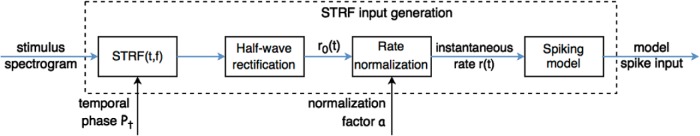
Illustration of model input generation process. The stimulus spectrogram was convolved with STRFs modeled after midbrain neurons, followed by half-wave rectification, then rate normalization to generate an instantaneous output-firing rate. This firing rate was then used to generate spikes using a spiking model (see Materials and Methods for details). The values of temporal phase Pt and normalization factor a used were reported in Table 2.